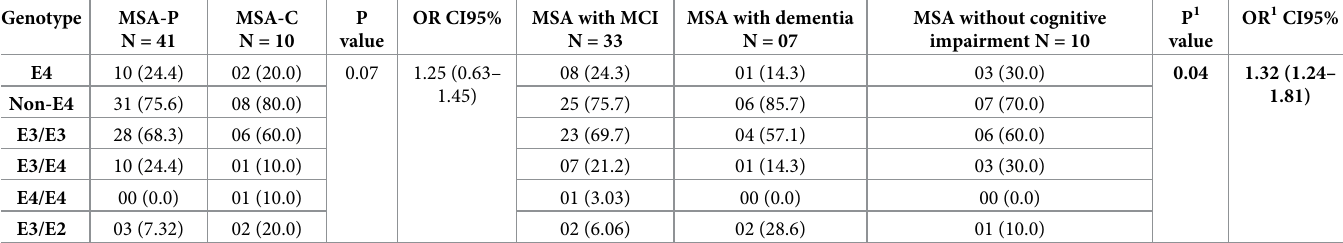
Table 2. Comparison of APOE variants in MSA patients with and without